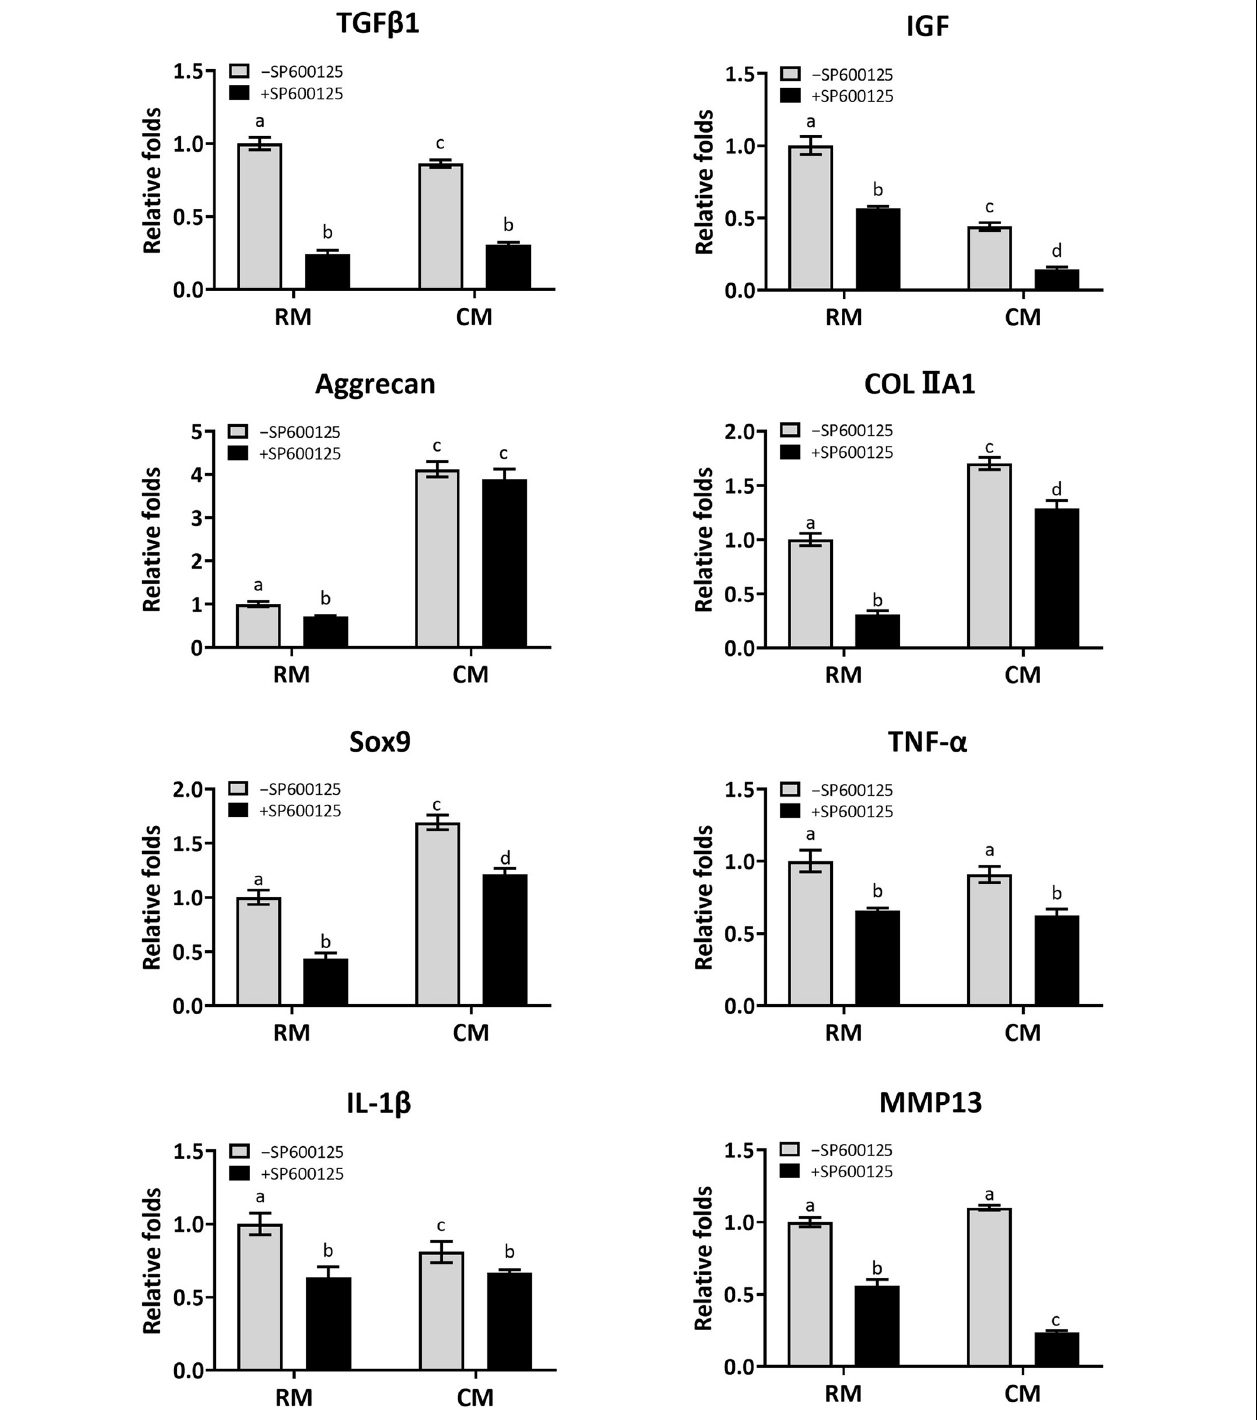
FIGURE 7 | Analysis of the expression levels of cartilage-related genes and inflammatory-related genes of in vitro cultured cartilages. After the samples were cultured in vitro for 8 weeks, the expressions of cartilage-related genes ( TGF- β 1 , IGF , Aggrecan , COLIIA1 , and Sox9 ) were greatly reduced when treated with SP600125 alone. However, the CM + SP600125 culture reversed the inhibitory effect of SP600125 alone on ECM synthesis. The expressions of TGF- β 1 and IGF were also downregulated in the CM-SP600125 group, which was probably caused by feedback inhibition with the high contents of TGF- β 1 and IGF in CM. Expressions of inflammatory-related genes ( TNF- α and IL-1 β ) and of MMP13 , which are involved in ECM catabolism, were downregulated in the + SP600125 groups. Columns with the same letters indicate no statistically significant differences ( p > 0.05), whereas the columns with different letters indicate statistically significant differences ( p < 0.05). RM, regular medium; CM, chondrogenic medium; ECM, extracellular matrix; and MMP13, matrix metalloproteinase 13.